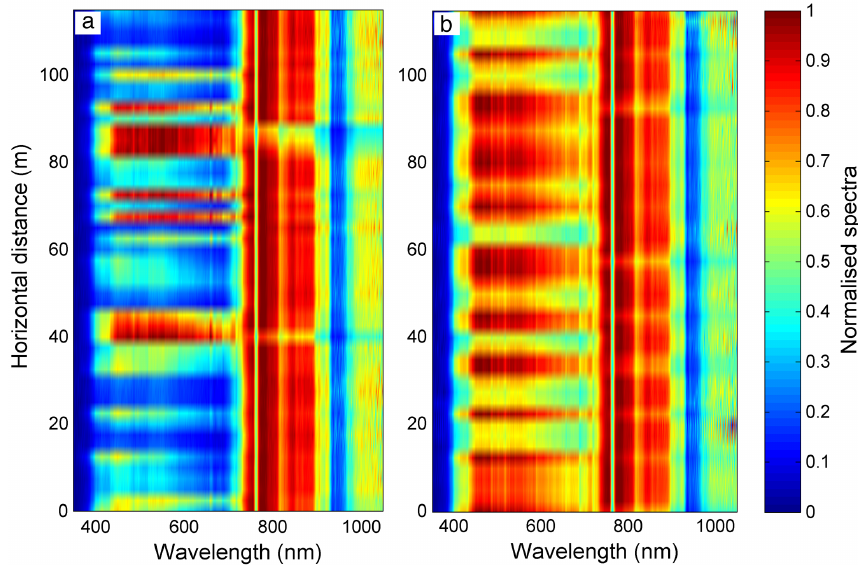
Figure 7. Normalised spectra along the 115m transect on the clear (a) and on the overcast day (b) respectively, showing clearly the distribu- tion of sunflecks and open spaces (on the clear day) and the thinning lines on the overcast day (b) .